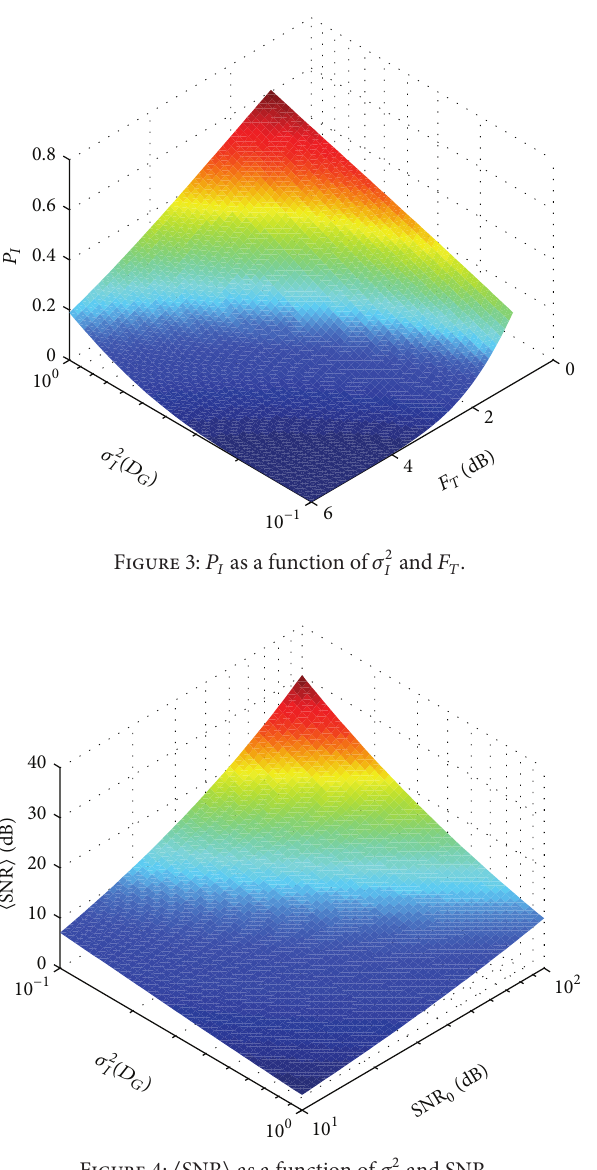
Figure 4: ⟨ SNR ⟩ as a function of 𝜎 2 𝐼 and SNR 0 .